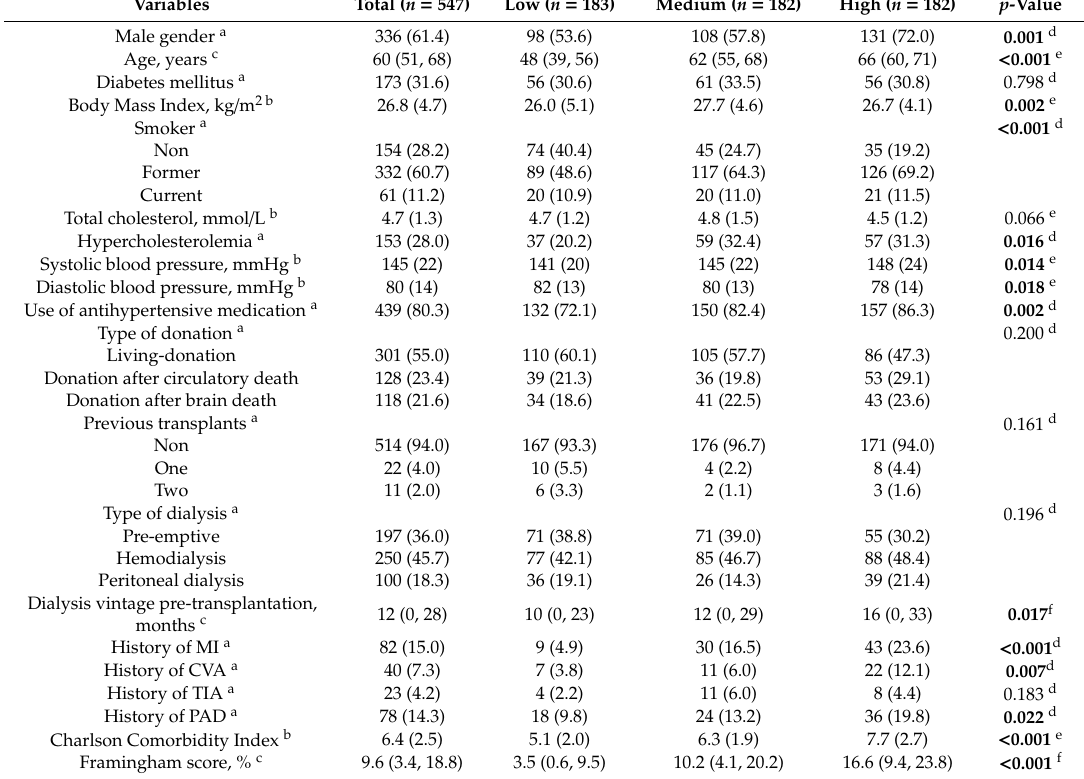
Table 1. Patient characteristics.